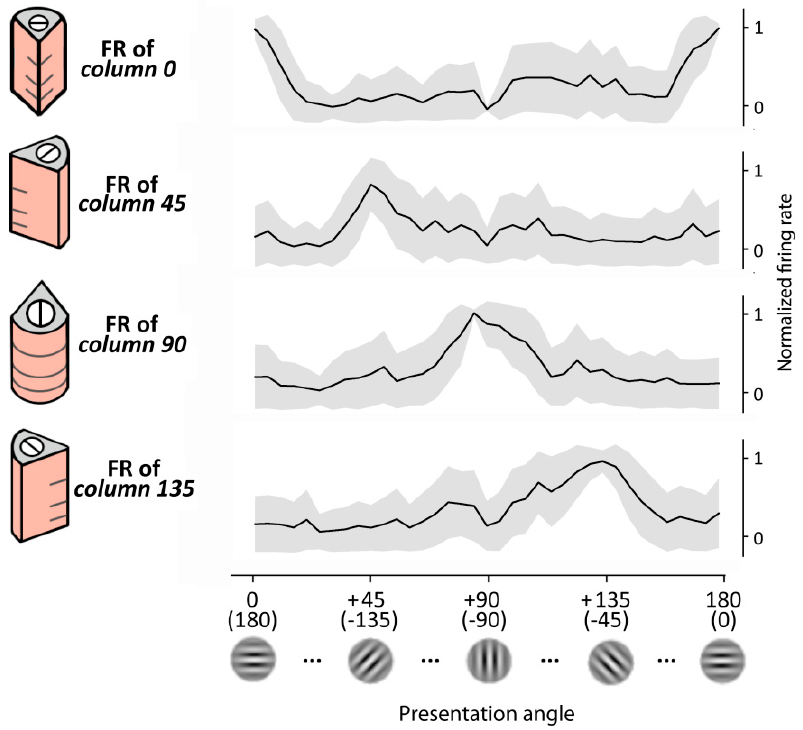
Figure 5. Orientation selectivity of each cortical column of the reduced pinwheel of the RVSM. A set of 37 Gabor patches were presented to the model for 30 trials. Each of the four subplots represents the firing rate (FR) of layer II/III pyramidal neurons of the column indicated in the y-axis after the presentation of the Gabor patches with orientation indicated in the x-axis. The more the angle of the presented stimulus is similar to the preferred orientation of the column, the higher the FR generated by the latter. The values obtained from each set of presentations have been normalized to the maximum FR obtained in each column. For a comparison with typical orientation tuning curves of neurons of the V1, see, e.g., [67].